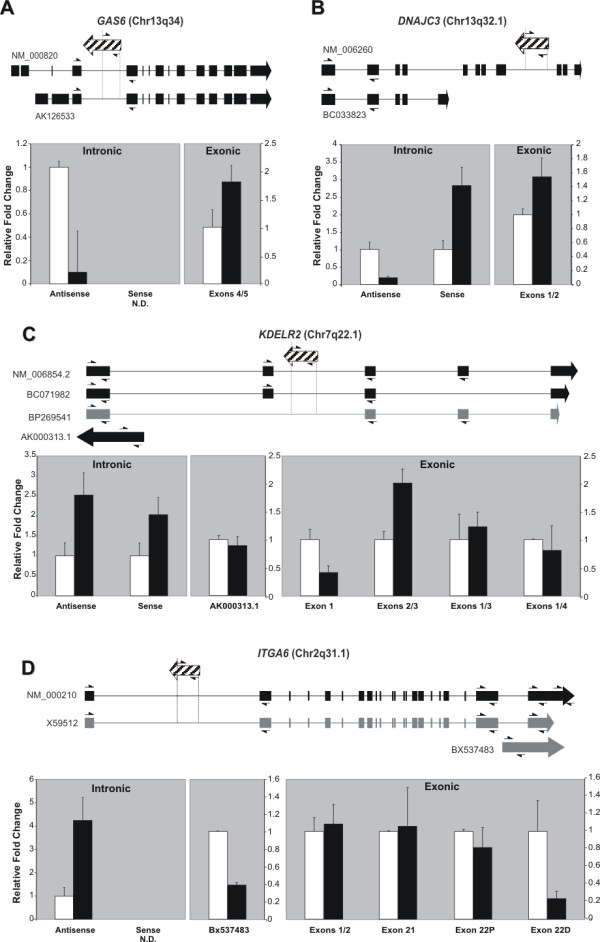
Antisense intronic transcription may regulate the levels and the post-transcriptional processing of sense protein-coding mRNAs. (A-D) Expression levels of sense, antisense intronic transcripts ("intronic" panels) or specific exons of protein-coding messages ("exonic" panels) from GAS6 (A), DNAJC3 (B), KDELR2 (C) or ITGA6 (D) loci were measured in androgen-treated (black bars) or control cells (white bars). Full-length curator-confirmed mRNAs mapping to each loci are shown as black arrows; non-curator-confirmed mRNAs and ESTs are shown by gray arrows; androgen-regulated intronic unspliced transcripts are shown by hashed arrows. Relative fold change (Y axis) indicates the increase or decrease in transcript levels after androgen-treatment relative to their levels in untreated control cells. Error bars refer to standard deviations relative to mean fold-change values.